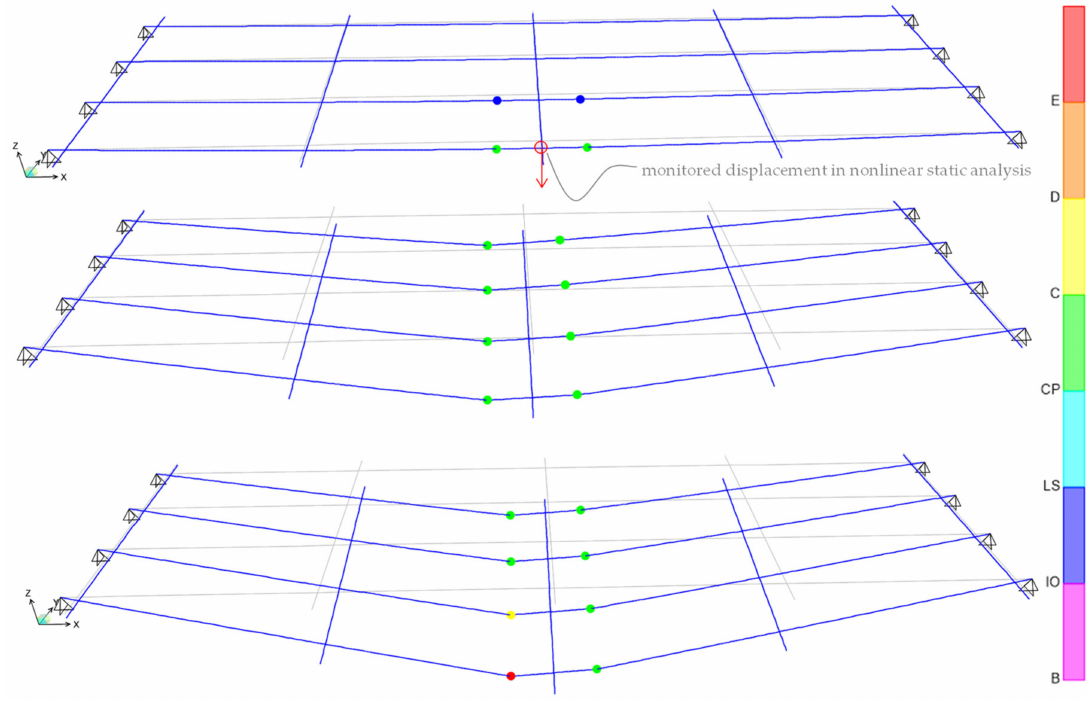
Figure 19. Deformed shape and plastic hinge development corresponding to three incremental loading steps (of increasing magnitude) during the nonlinear static